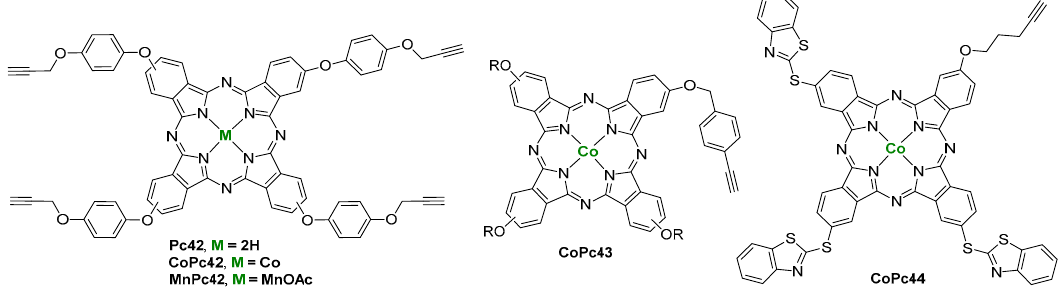
Figure 5. Structures of Pc42 , MPc42 , CoPc43, and CoPc44 .